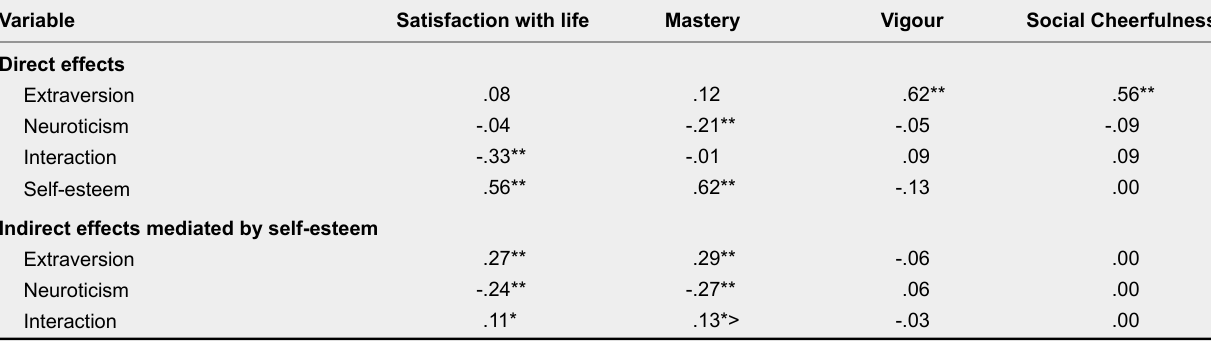
Direct and Indirect Effects on SWB Dimensions.